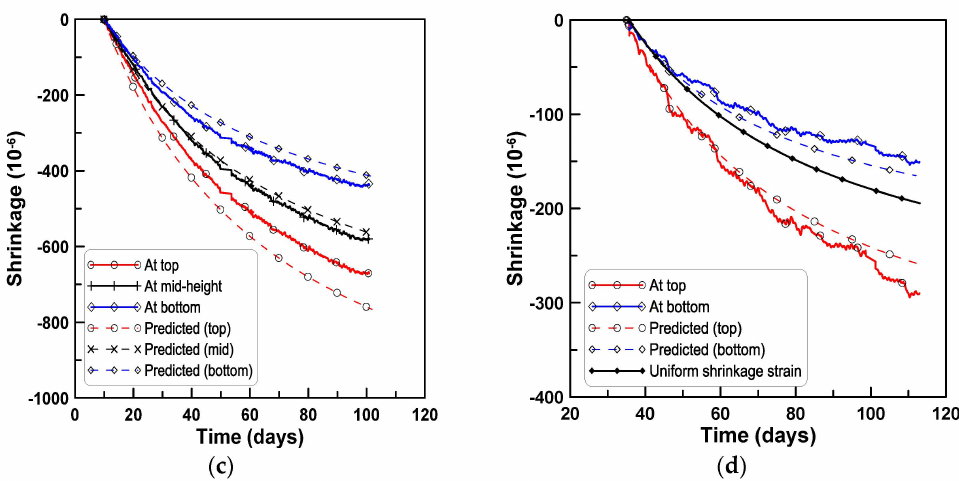
Figure 13. Comparison of measured and predicted shrinkage strains within beam depth for test series A, B, C, and D (test-based): ( a ) Test series A; ( b ) test series B; ( c ) test series C; ( d ) test series D.